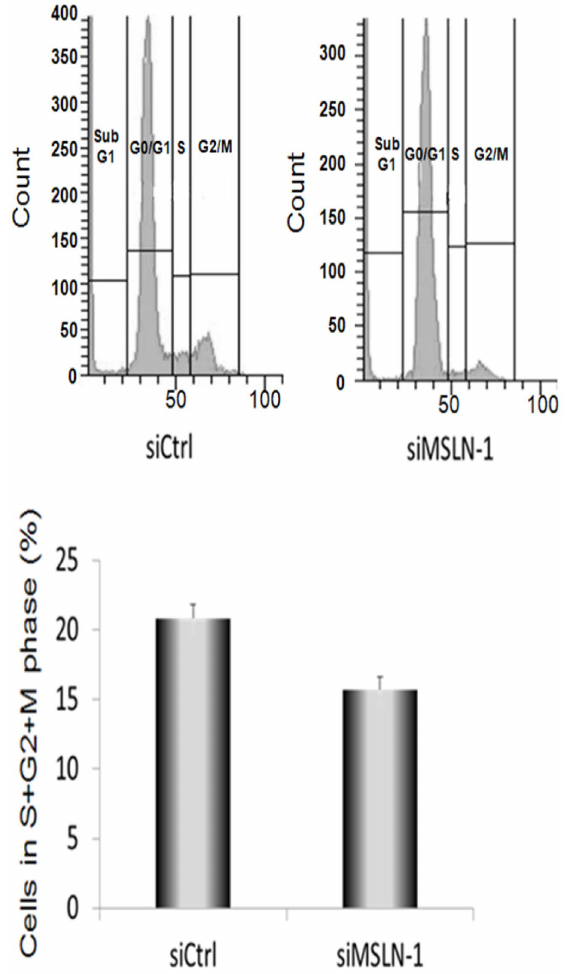
Figure 3. Progression of cells through the cell cycle following flow cytometry analysis. The graph shows the percentage of Mero- 14 cells in phase S + G2 + M treated with 40 nM of the siCtrl or siMSLN-1. The S + G2 + M phase of the cell cycle was slightly reduced following the treatment with siMSLN-1 (*P= 0.033). Error bars represent SEM of six independent